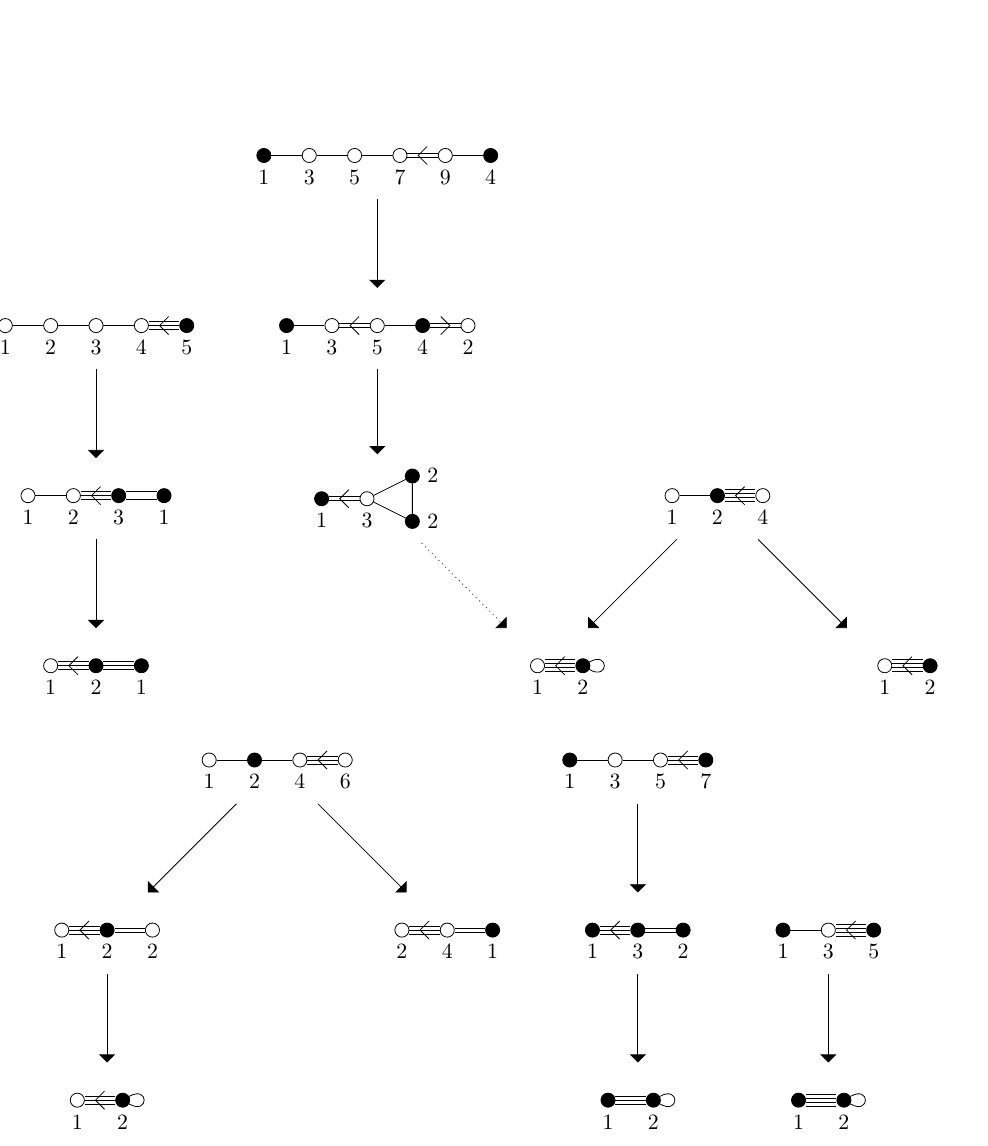
Figure 7 . The su (5) series (top left), the sp (8) su (3) series (middle) and the su (2) series